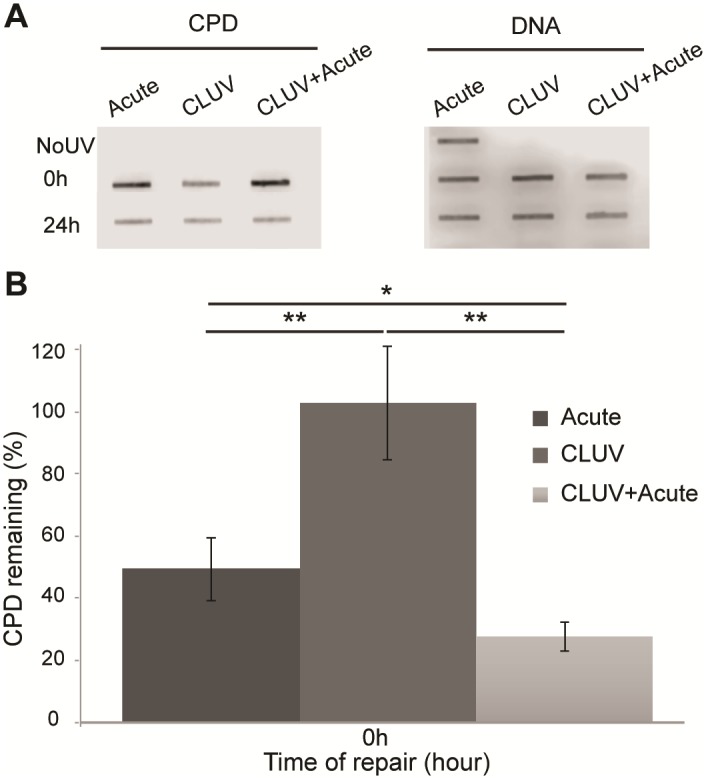
CPD repair rate is enhanced by the CLUV pre-stimulation in NHDF.(A) Immuno-slot-blot showing the level of CPD and DNA. NHDF were irradiated with a single UVB dose (Acute), a CLUV irradiation or a CLUV followed by a single acute UVB dose (CLUV+Acute), as described in Fig 1. Zero and 24 h post-irradiation, DNA was harvested and applied on a membrane. Revelation of CPD and DNA was performed using specific monoclonal antibodies. NoUV is used as a negative control and DNA as a loading control. (B) Representation of the quantity of CPD repair after different UVB treatments. Quantitative analysis of the immuno-slot-blot detecting CPD is performed by measuring the signal intensity at each time points post-UV and compare it to the 0 h for each UVB treatment condition (Acute, CLUV, CLUV+Acute). The signal at 0 h corresponds to 100% of the CPD signal for each UVB treatment independently. The results then describe the CPD removal relative to the initial CPD amount for each UVB treatment (Acute, CLUV and CLUV+Acute). Normalization is performed using the corresponding DNA signal as previously [31]. Results are presented as means ± SEM. P-value was evaluated using the student’s t-test (*p < 0.05; **p < 0.01). Experiment was performed using 3 strain cells (N = 3) at least in duplicate (n = 2).